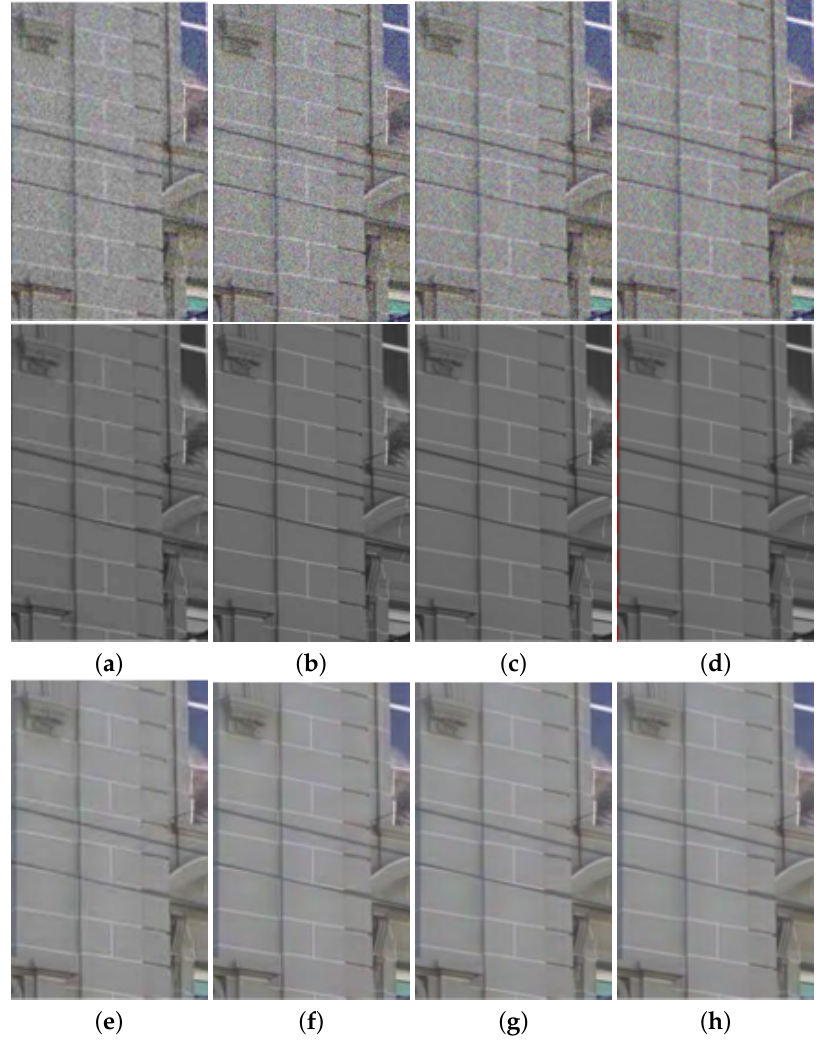
Figure 20. Fusion results from the proposed method on the compressed test images with different compression degrees: ( a ) 0.25; ( b ) 0.5; ( c ) 0.75; ( d ) png format; ( e ) Fusion results for ( a ); ( f ) Fusion results for ( b ); ( g ) Fusion results for ( c ); ( h ) Fusion results for ( d ). (From ( a ) to ( d ), top : RGB images; bottom : NIR